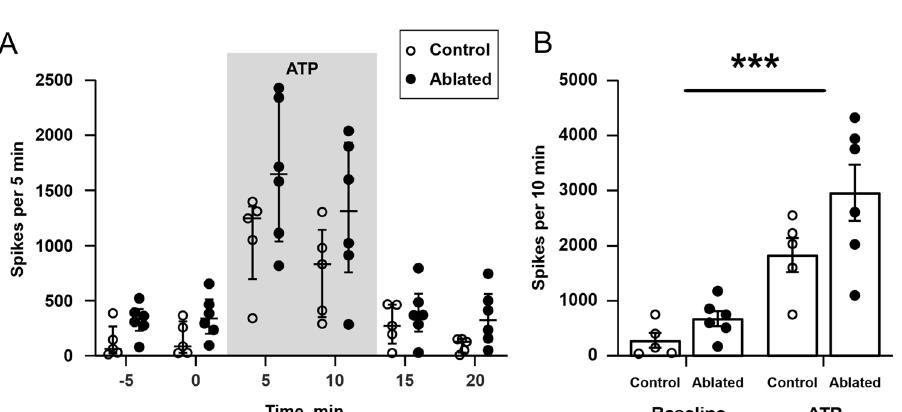
Figure 6. Direct spikes recording in control and in animals with AAV-ablated meningeal lymphatic system under basal conditions and ATP stimulation. ( A ) Number of nociceptive spikes recorded during 5 min bins (median with interquartile range) under basal conditions, during the application of 100 µM ATP, and during the following washout. ( B ) ATP induced a significant increase in nociception activity in both genotypes. *** p < 0.001 (baseline vs. ATP; n = 5/6 in control/ablated experimental group) by matched two-way ANOVA. Hemiskull preparations from mice with ablated lymphatics showed a non-significant trend for an increased response to ATP application ( p = 0.077 vs. control). Data presented as mean ±